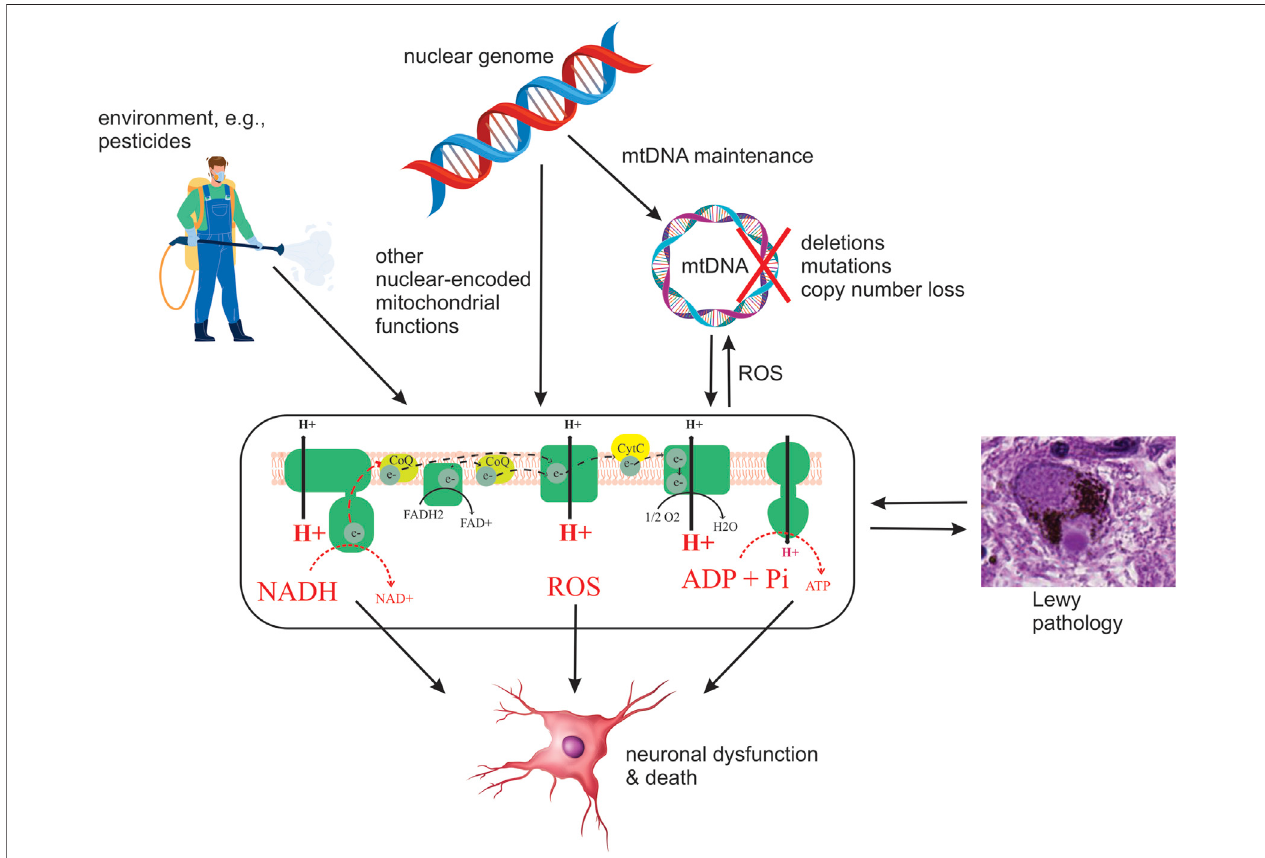
FIGURE 2 | Schematic depiction of current hypotheses on the origin and role of MRC de fi ciency in PD. Potential upstream etiologies are summarized, including genetic and environmental factors. Four potential downstream consequences of de fi cient MRC function are shown: decreased oxidation of NADH to NAD + by CI, decreased electron transfer, resulting in decreased proton pumping and, in turn, loss of membrane potential and lower ATP production, and increased generation of ROS. It should be emphasized that this is by no means an exhaustive list of possible causes or consequences of MRC de fi ciency in PD.